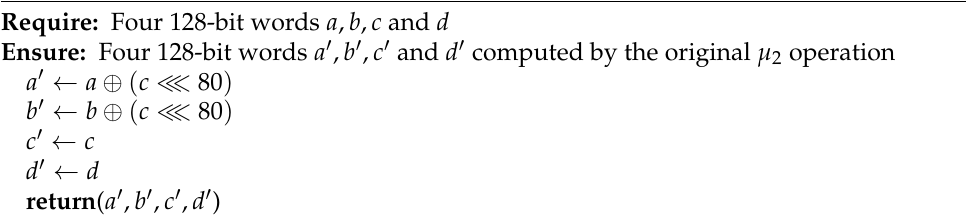
Algorithm 3 Classical µ 2 operation of the FRIET-P round.